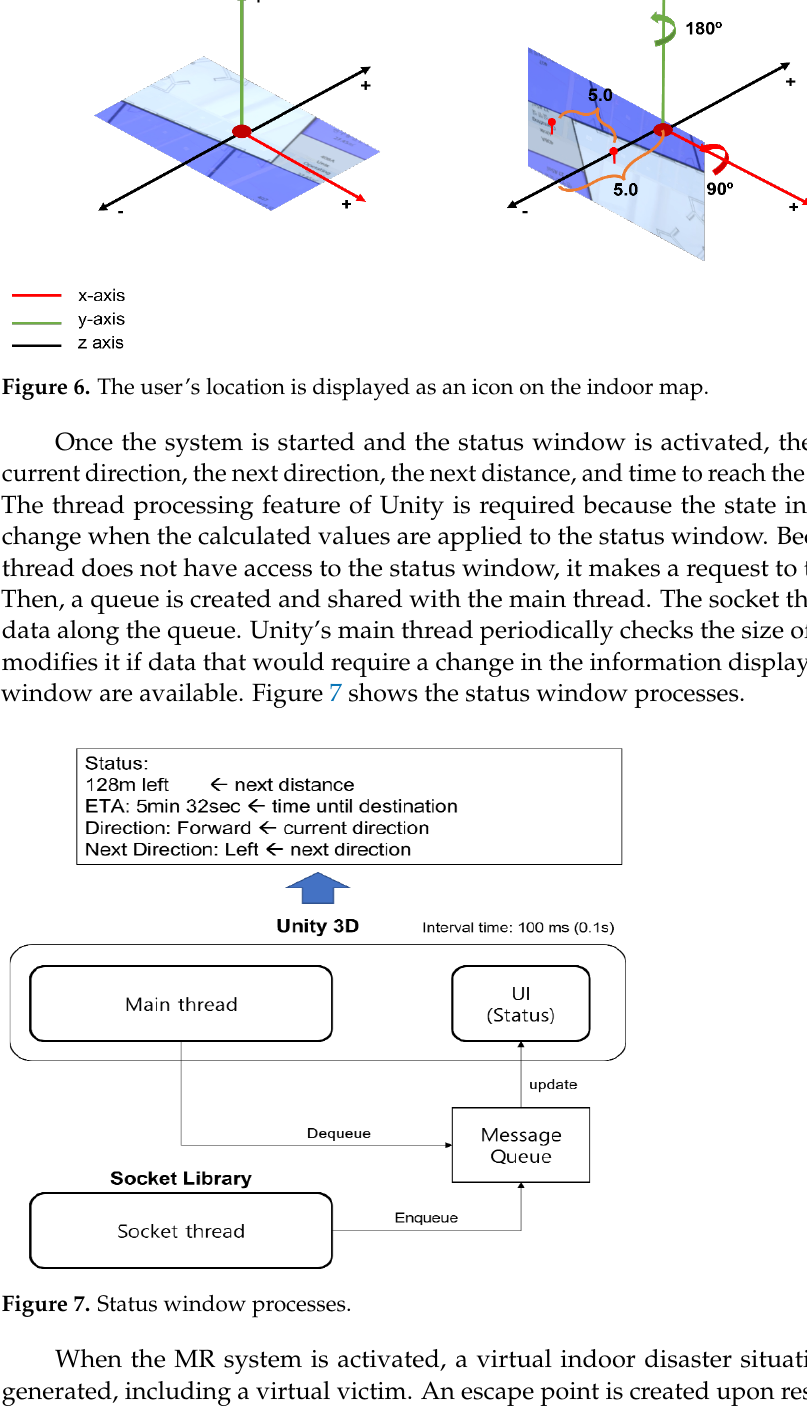
Figure 8. Navigation function guiding the user toward the victim and exit. As stated above, the MR system simulates disaster situations requiring the rescue of victim/s. Pre- mapped spatial data are stored in the device’s memory. When activated, the system randomly generates virtual disaster sites and victims asynchronously. A button corresponds to the victim’s location; when the button is clicked, th e victim object is deac- tivated (i.e., they are rescued). Figure 9 shows a schematic of the indoor virtual disaster.